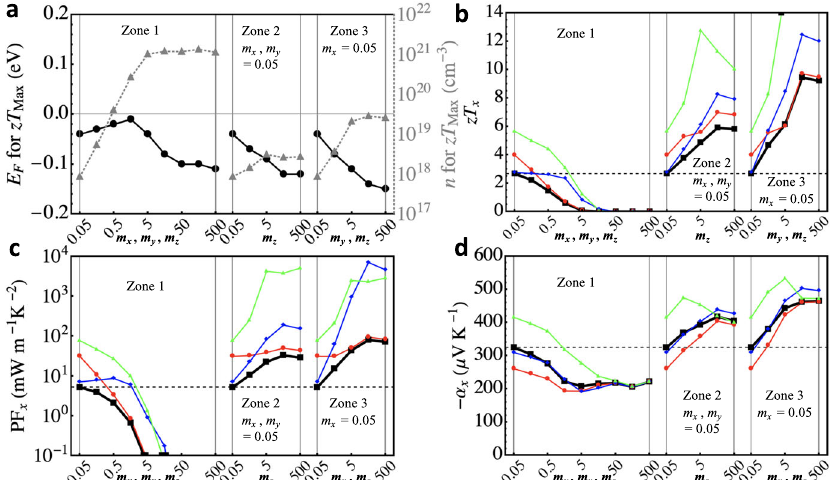
Fig. 2 Single-band thermoelectric properties in the light direction ( x ) with m x = 0.05 with respect to its effective-mass pro fi le. a Fermi level and carrier concentrations at optimum zT , b optimum zT , c the power factor, d and the Seebeck coef fi cient, in the x -direction. Each zone (as enclosed by vertical gray lines) indicates certain characteristic evolution: isotropic increase in m from 0.05 to 500 in Zone 1, anisotropic increase in m y from 0.05 to 500 in Zone 2, anisotropic increase in both m y and m z in Zone 3 from 0.05 to 500. Four different scattering regimes are considered: the POS limit (blue), the IIS limit (green), the DPS limit (red), and the overall effect (black). Supplementary results for σ , μ , ζ , κ e , L , z e T are in Supplementary Fig.